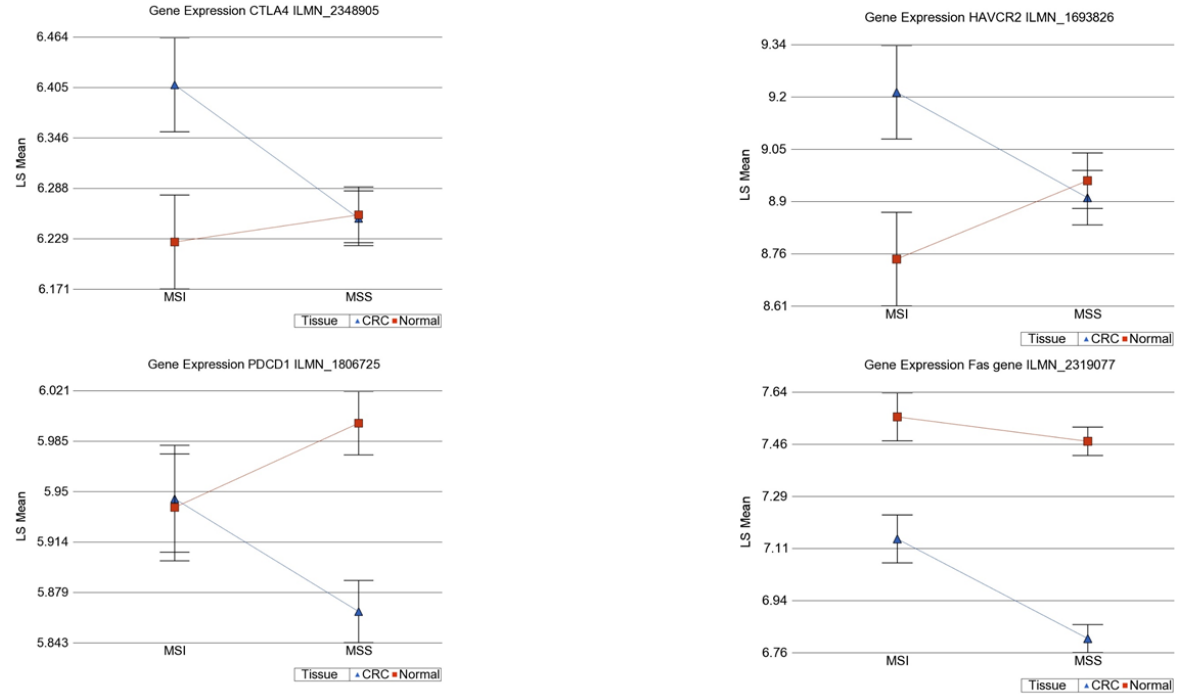
Figure 10. Interaction of MSI status and gene expression pattern of immune target genes.